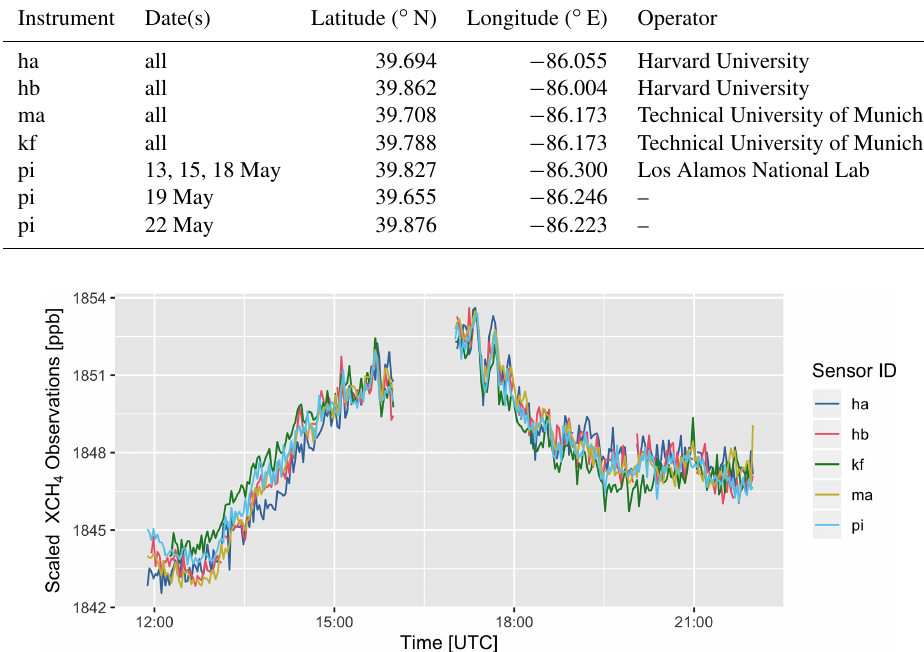
Figure 2. Total column dry mole fraction methane (XCH 4 ) for the five instruments on 1 of the 2 side-by-side intercomparison days. Calibra- tion scaling factors have been applied to these